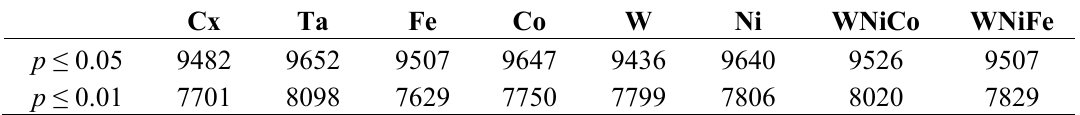
Table 2. Rat data comparison between actual numbers of features accurately expressed in each exposure group at the detection p -value ≤ 0.05 and ≤ 0.01.